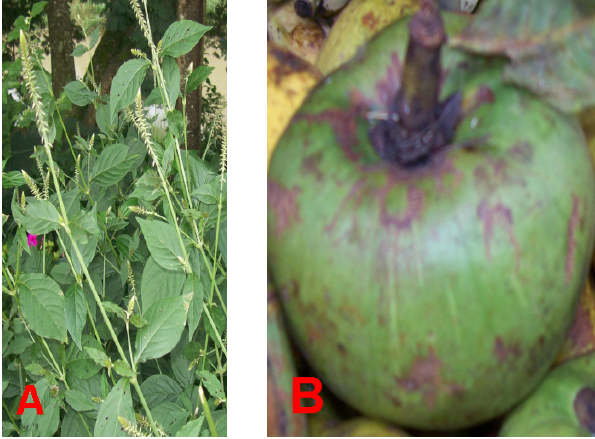
Fig. 2. Plants used as mordants, (A) Achyranthes aspera and (B) Garcinia xanthochymus